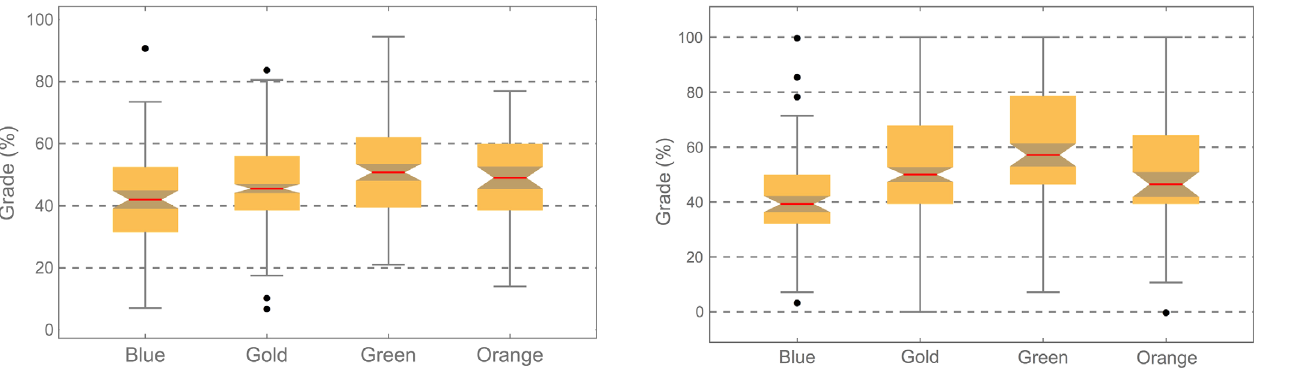
FIG. 6. Box plots of grades on test 2 for different personality types.